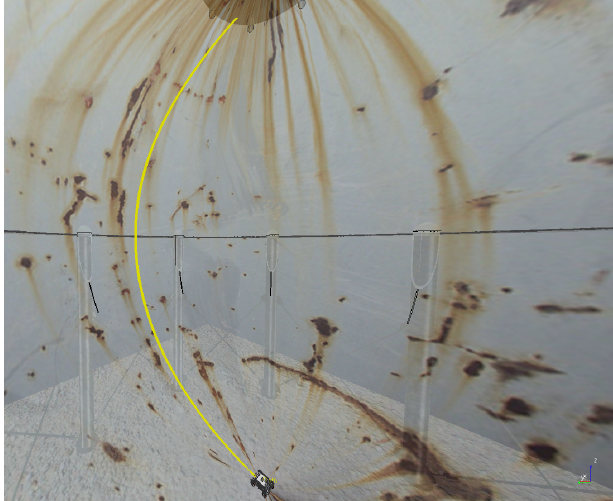
Figure 14. Robot trajectory while climbing the LPG